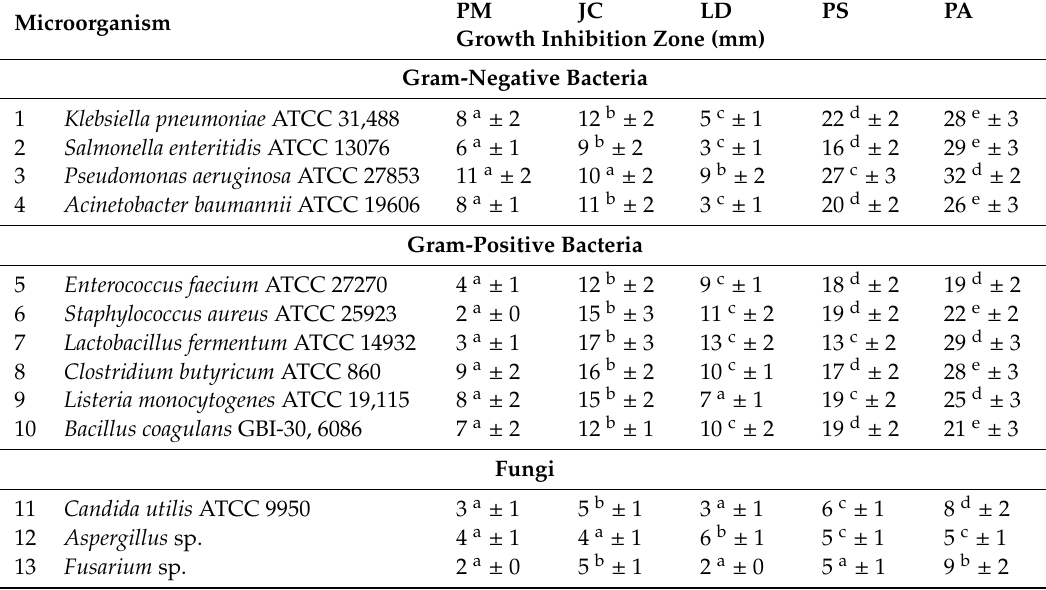
Table 4. Antimicrobial properties of tested conifer